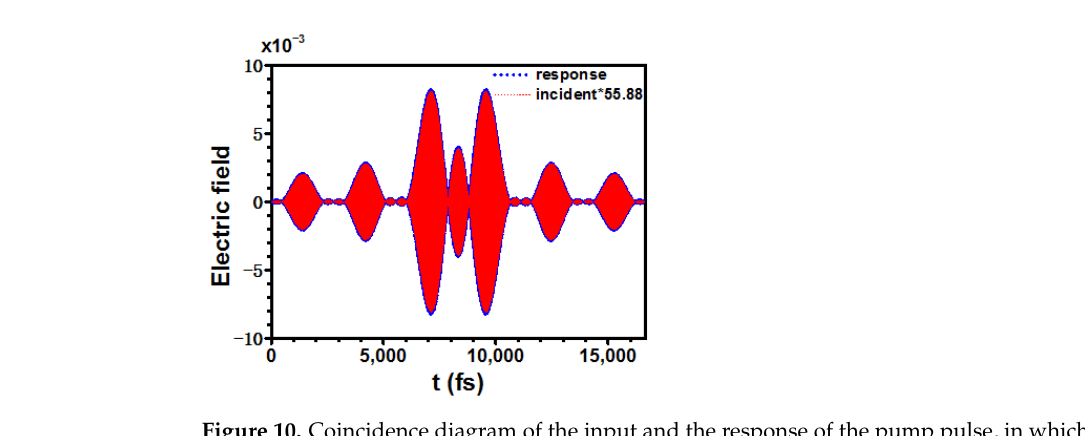
Figure 10. Coincidence diagram of the input and the response of the pump pulse, in which the input pulse is amplified by 55.88 times and the output pulse moves forward by 31 fs.